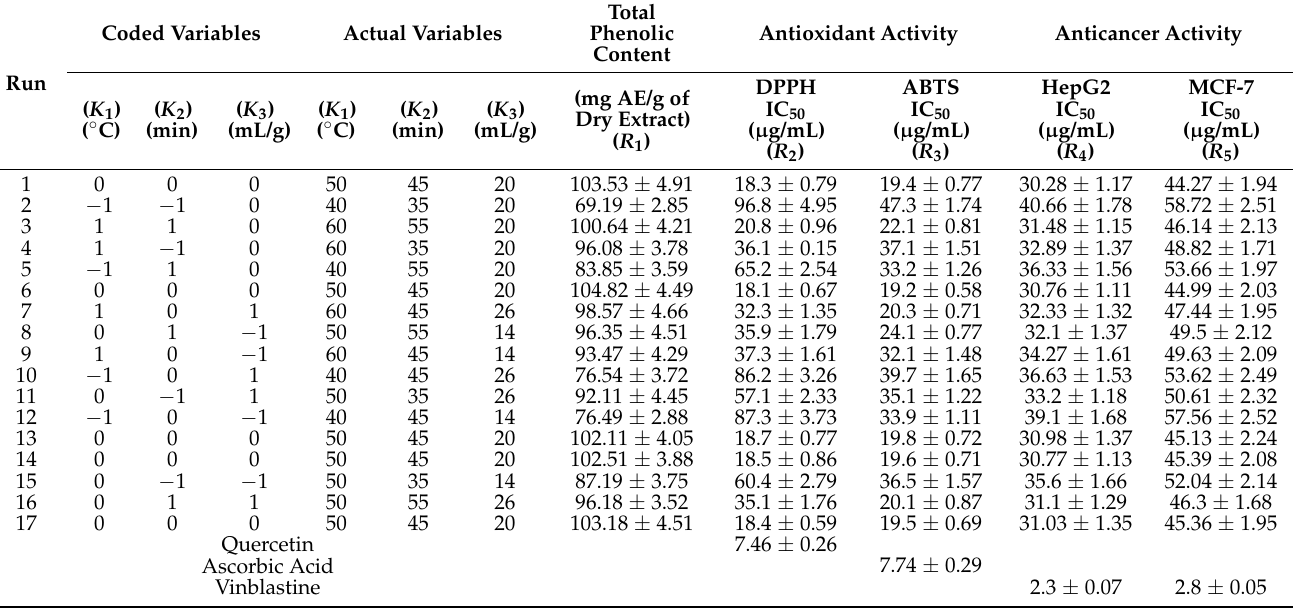
Table 2. Box–Behnken design (BBD) with the observed response of the dependent variables (TPC, DPPH, ABTS, HepG2, and MCF-7) from the UAE of P. schimperi (aerial parts).